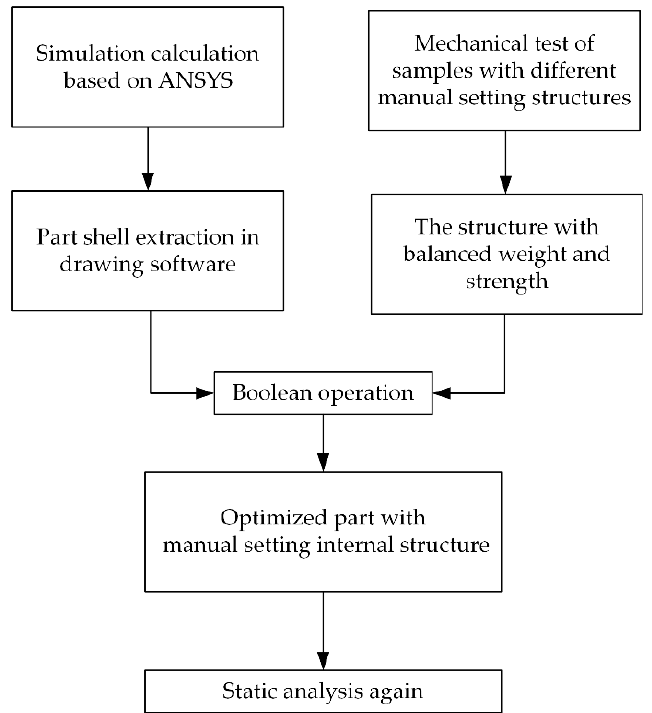
Figure 3. Manual lightweight